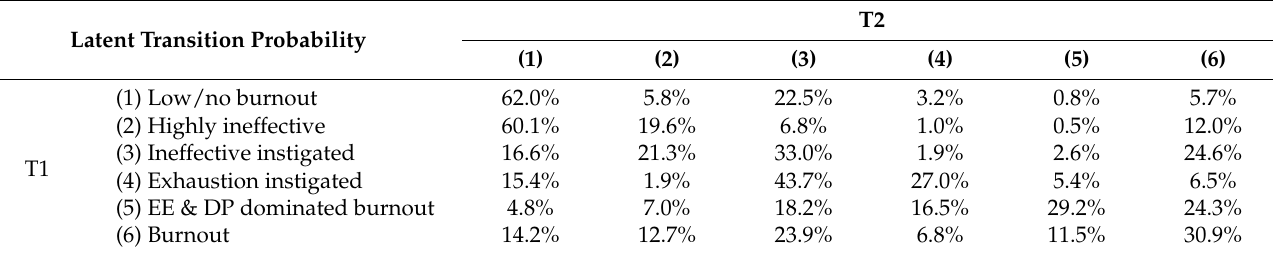
Table 3. Latent transition probability of each profile from T1 to